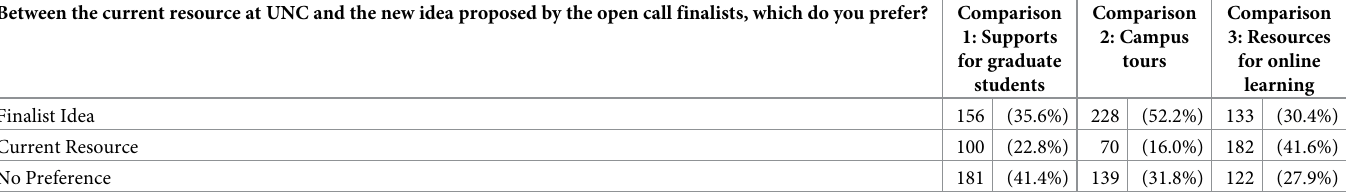
Table 3. Survey participants’ preferences for open call finalists’ COVID-19 safety strategies compared to currently existing resources at UNC (N = 437). Between the current resource at UNC and the new idea proposed by the open call finalists, which do you prefer? Comparison